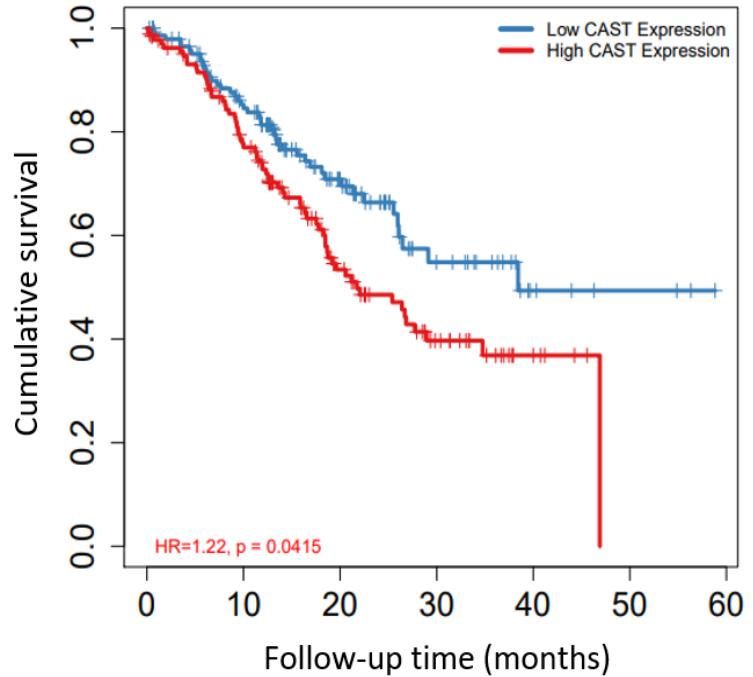
Figure 5. Cumulative survival for high and low CAST expression in GC. 5-year survival was evaluated.